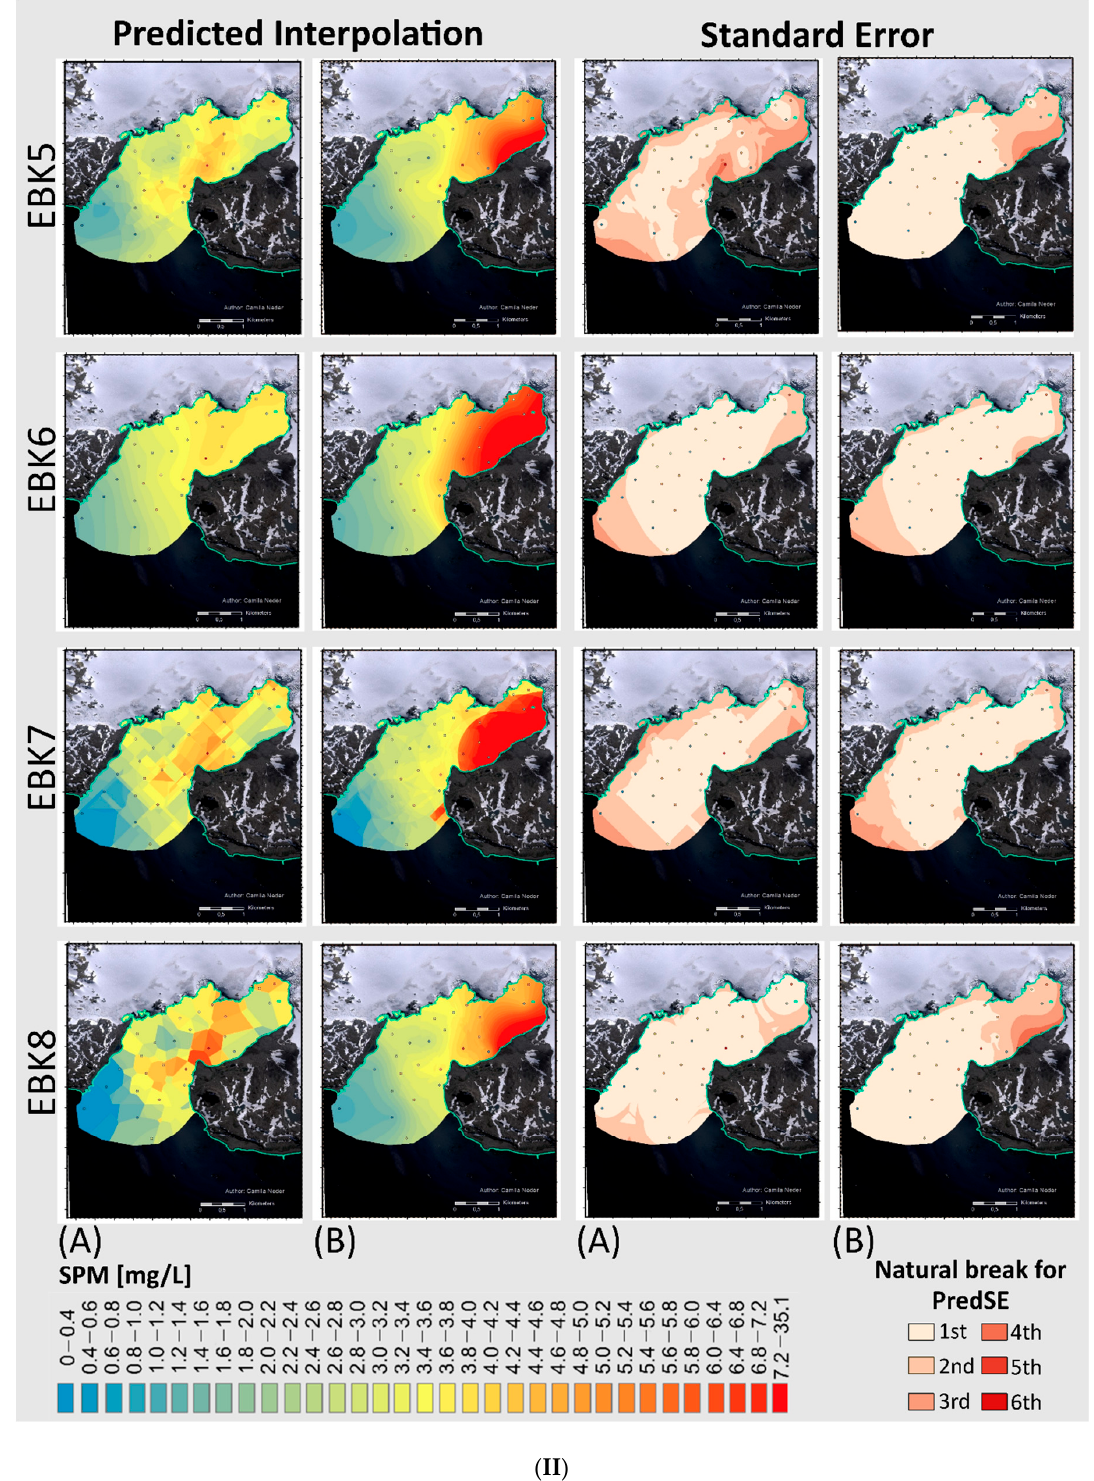
Figure 7. ( I ) Predicted suspended particulate matter (SPM) interpolations and predicted standard error (PredSE) maps for one mean meteorological summer day ( A ) without and ( B ) with meltwater streams SPM concentration data (continued in II ). Eight tuned geostatistical models: Simple Kriging (SK), Ordinary Kriging (OK), and Empirical Bayesian Kriging (EBK) models The SK2A model in Figure 7I, was not performed because the trend removal with optimization was not applicable due to a required estimation of the tendency at each location instead of a general one.